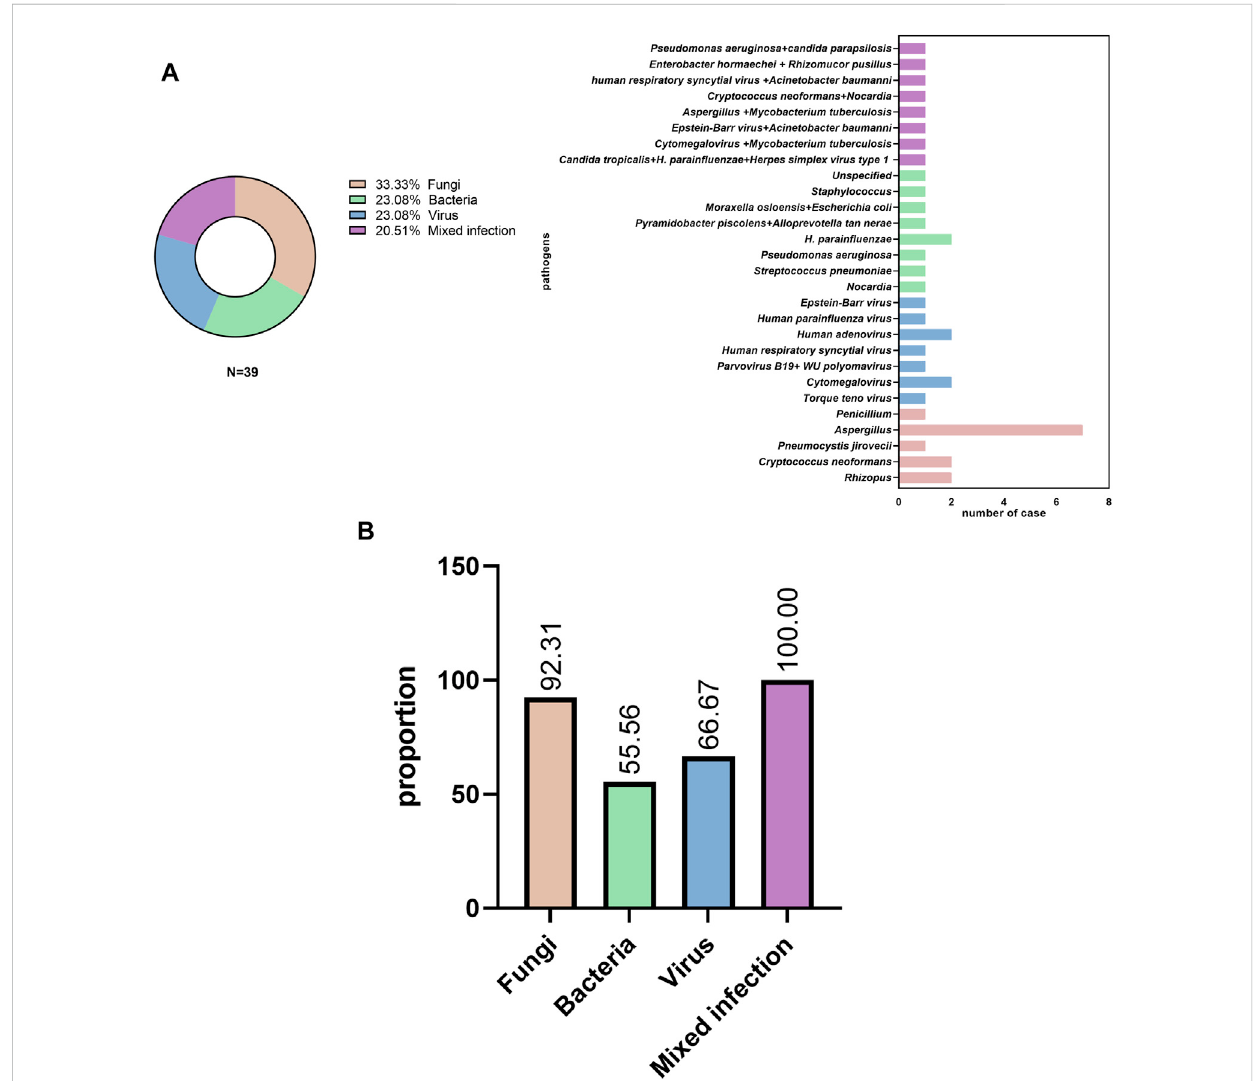
FIGURE 2 Pathogen distribution (A) in pulmonary infectious disease and (B) initial empiric antibiotic treatment.